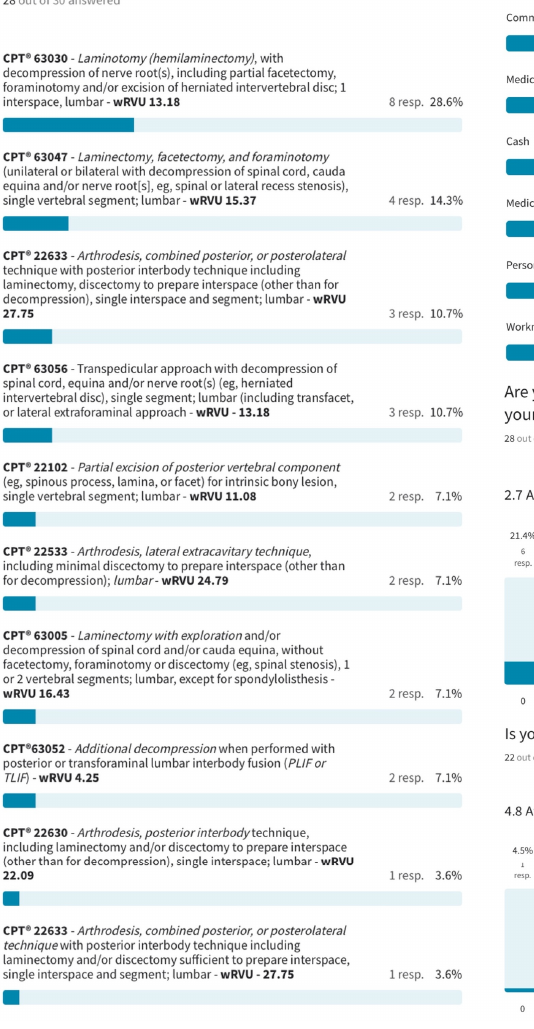
Figure 2. Of the responding surgeons, 85.8% valued the wRVU over 13, 46.6% over 15, and 14.3% over 20. Considering multiple responses, surgeons’ revenue for the endoscopic procedure was most frequently generated by commercial insurance (75%), Medicare (70.8%), cash payments (50%), Medicaid (45.8%), personal injury settlements (33.3%), and workmen’s compensation (25%). Only 3 of the 30 surgeons who filled out a complete survey thought they were adequately paid considering the complexity and the intensity of the lumbar endoscopic decompression surgery. Most surgeons (78.5%; <50th percentile) did not think they were adequately compensated. Regarding facility reimbursement, 77.3% of surgeons reported that their healthcare facility struggled to cover the cost with the received